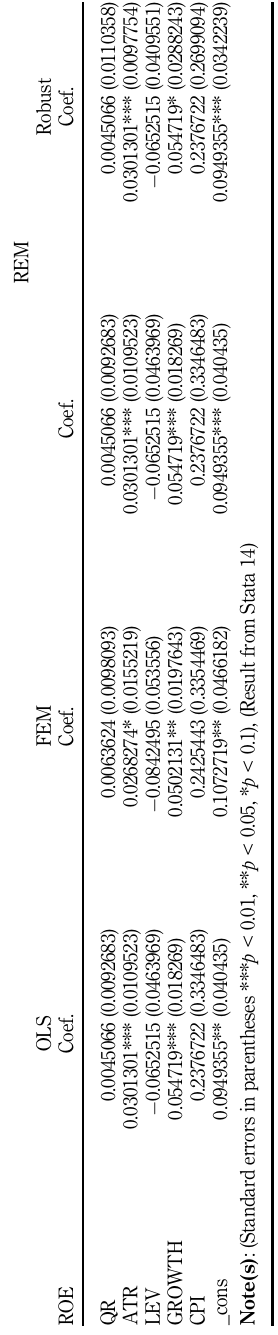
Table 7. Regression